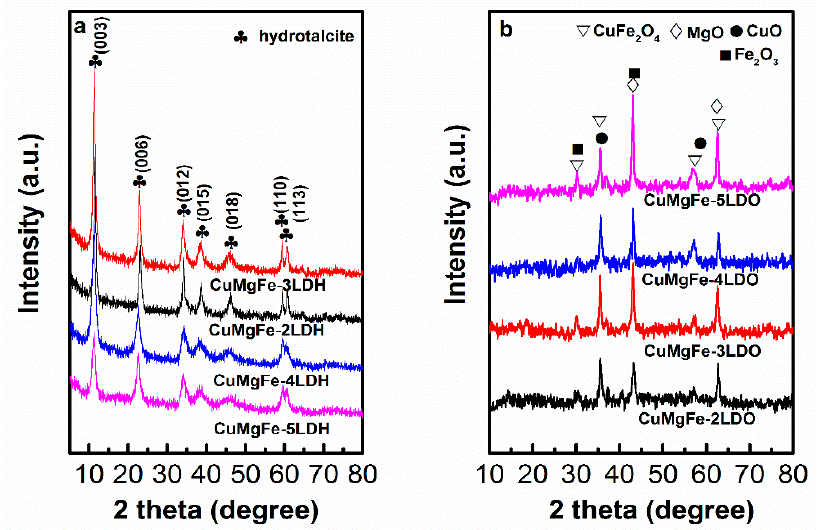
Figure 1. XRD patterns of ( a ) CuMgFe-xLDH and ( b ) CuMgFe-xLDO. The XRD patterns of CuMgFe-xLDO catalysts with different (Cu + Mg)/Fe molar ratios are shown in Figure 1b. After calcination at 600 ◦ C, all LDHs were transformed to mixed oxides and spinel phase. For all the CuMgFe-xLDO samples, the diffraction peaks at around 30.2 ◦ , 35.5 ◦ , 57.1 ◦ , and 62.7 ◦ corresponded to the (220), (311), (511), and (440) planes of CuFe 2 O 4 spinel phase (JCPDS card no. 77-0010), respectively. Meanwhile, the CuO phase (at around 35.5 ◦ (002) and 58.3 ◦ (202)) also might be present, but its diffraction peaks were partially overlapped with those of CuFe 2 O 4 . Consequently, it was difficult to distinguish in the XRD results. The diffraction peaks at 30.3 ◦ and 43.3 ◦ could correspond to the (220) and (400) planes of the Fe 2 O 3 phase (JCPDS card no. 39-1346),